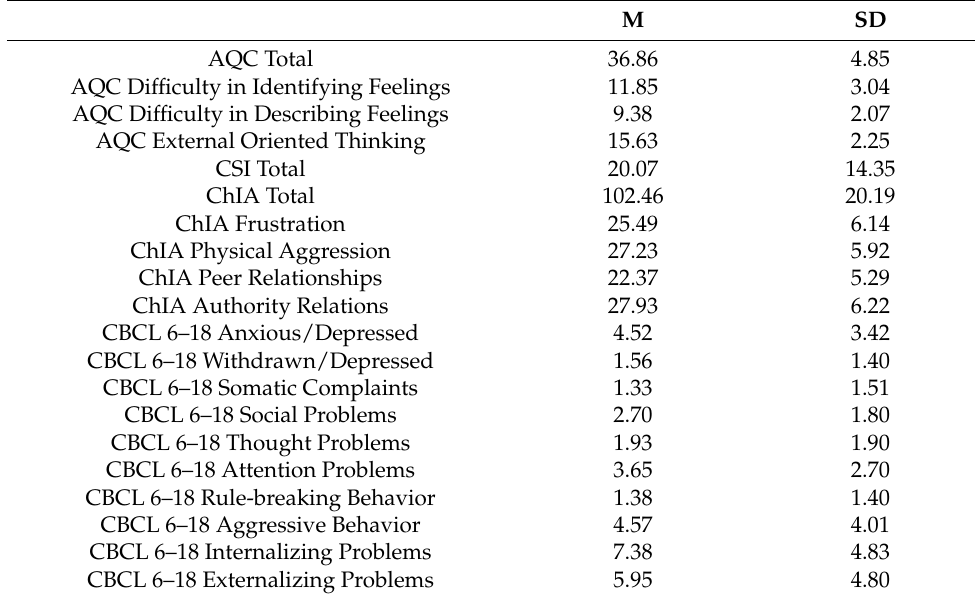
Table 1. Children’s psychological